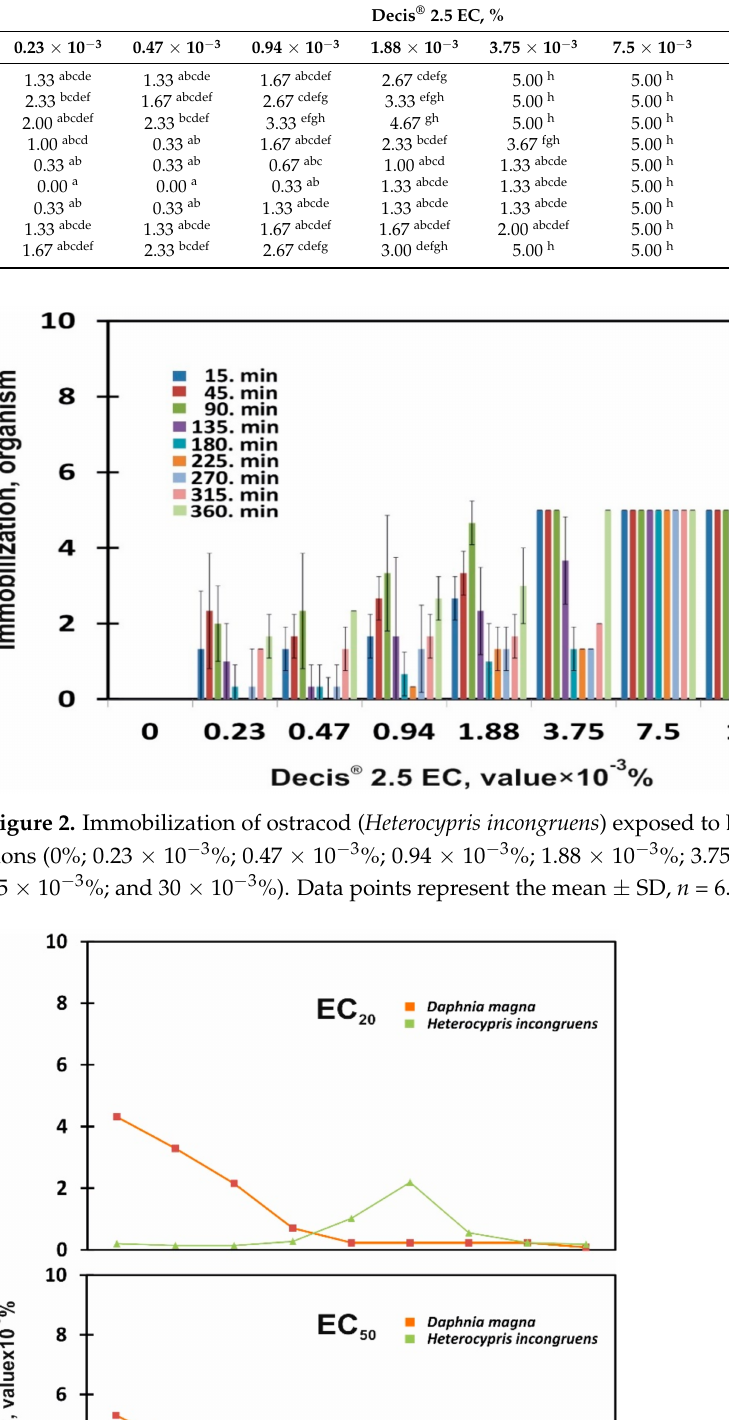
Table 5. The immobilization of Heterocypris incongruens exposed to Decis ® 2.5 EC. The table contains the mean of the examined features and in superscript the level of significance (a–h).